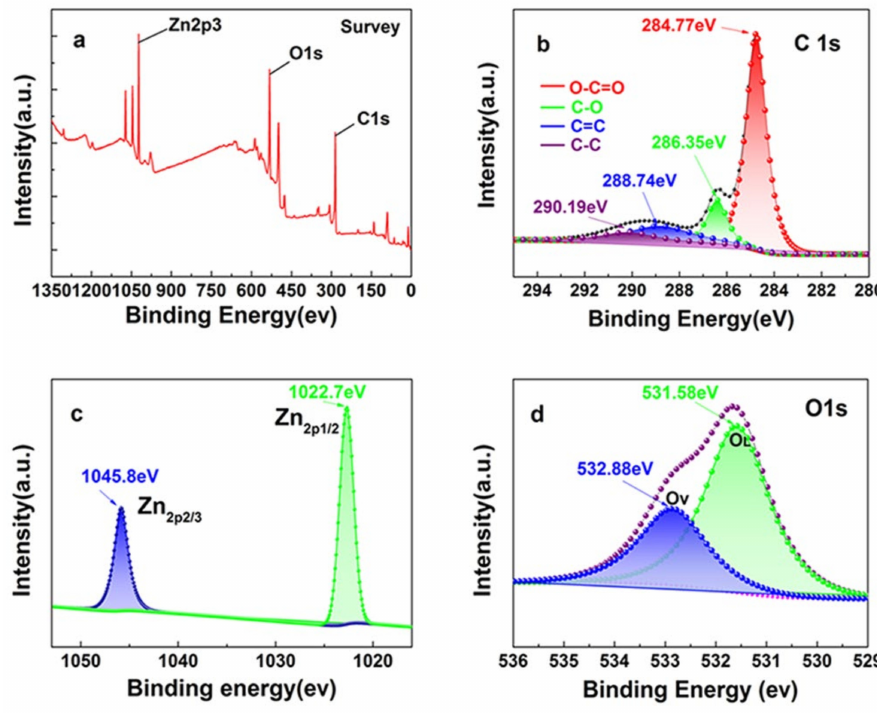
Figure 5. ( a ) XPS survey spectrum of ZnO@BC; ( b ) C 1s; ( c ) Zn 2p 1/2 and 2p 3/2 ; ( d ) O 1s.